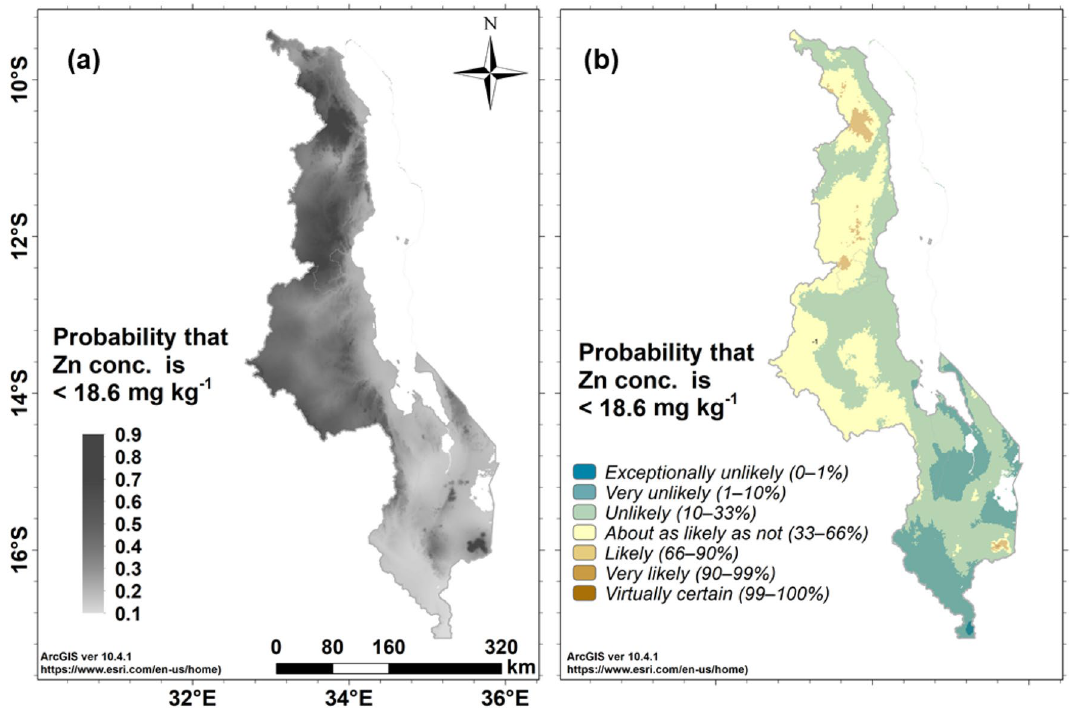
Figure 5. Probability that the concentration of Zn in maize grain across Malawi is < 18.6 mg kg −1 based on ( a ) numerical scale, ( b ) expressed according to ‘calibrated